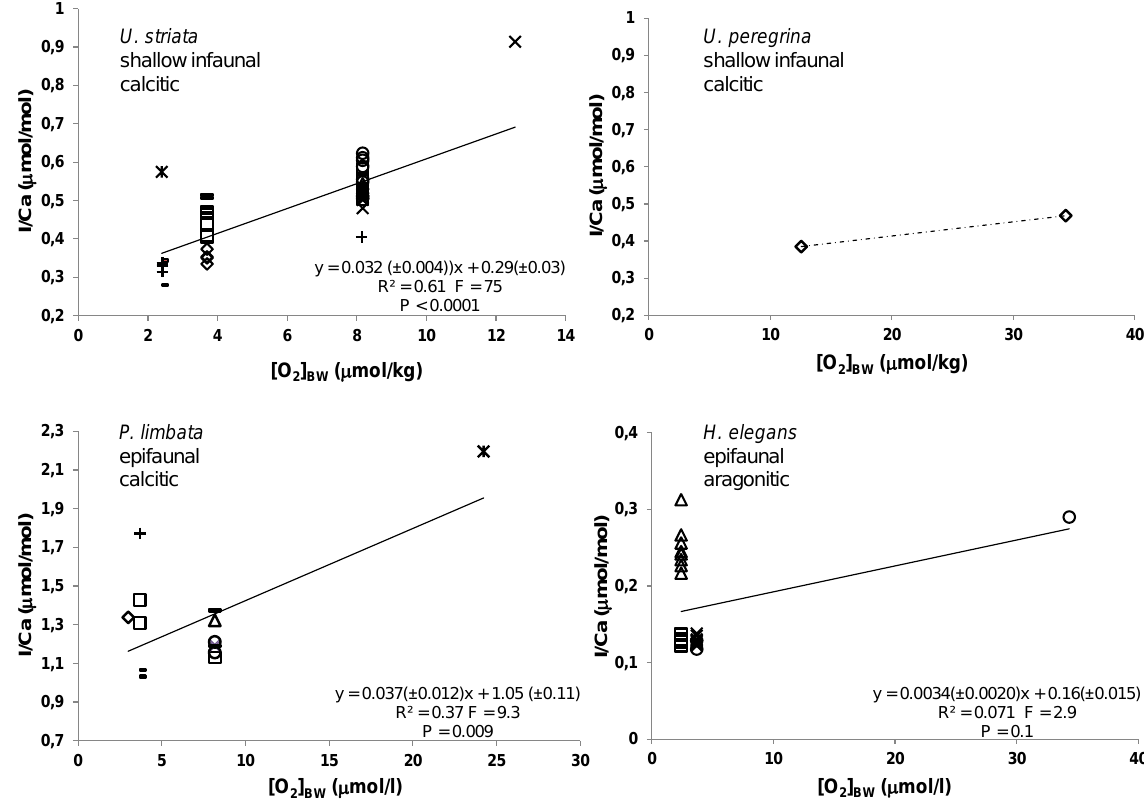
Figure 5. Correlation of I / Ca ratios with bottom water oxygen concentrations [O 2 ] BW for the four analysed benthic foraminiferal species. Different symbols at the same locations indicate that measurements were done on different sample assemblages from the same sampling site. Significances were calculated with an ANOVA. The dashed line is just for orientation, because no correlation could be calculated with only two data points. The mean precision for the foraminiferal analyses in this study was species dependent: 1 σ mean = 3 . 2% ( U. striata ; n = 65), 4.21% ( U. peregrina ; n = 2), 2.0% ( P. limbata ; n = 18) and 7.4% ( H. elegans ; n =